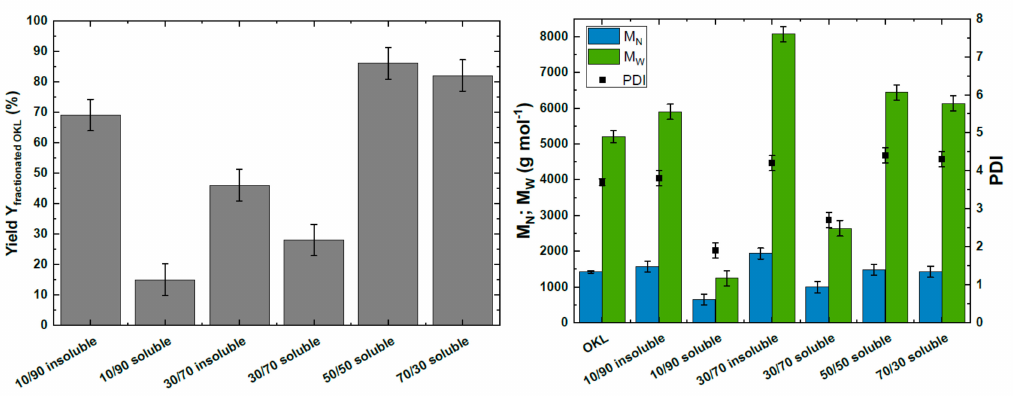
Figure 3. Yield Y of fractionated OKL ( left ) and M W , M N , and PDI of OKL and of fractionated OKL ( right ) after solvent fractionation in 10 / 90, 30 / 70, 50 / 50, and 70 / 30 acetone / water ( v / v )